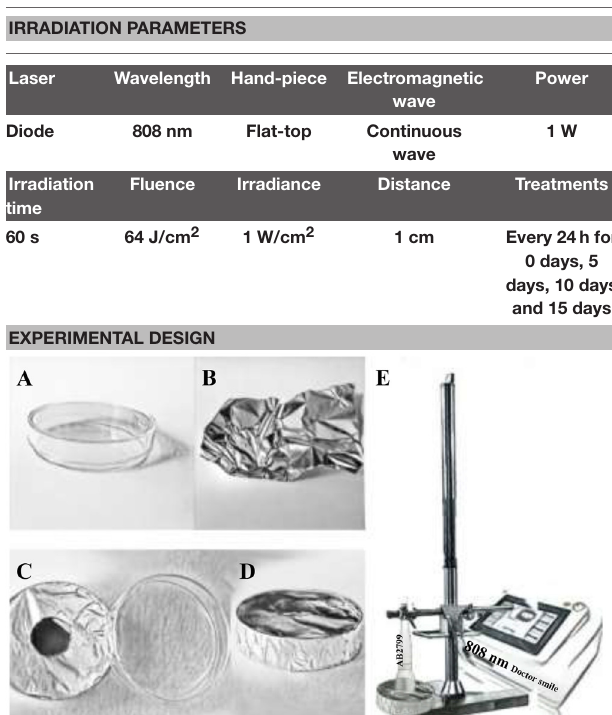
TABLE 1 | Description of the irradiation parameters and the experiments’